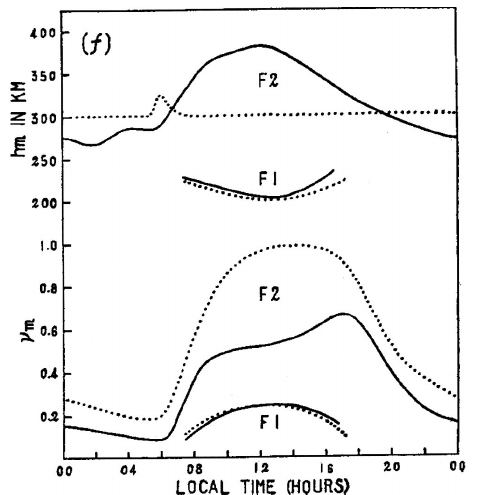
Figure 2. Theoretical models of the daily variation of the F2 layer at the geomagnetic equator. In the model where the vertical drift is taken into account (solid curve) the depression in density that had been observed as “equatorial anomaly” was reproduced, while the Chapman layer (dashed curve) was peaked at noon. Top: virtual height and bottom: electron density at the F2 peak (Hirono and Maeda, 1954).